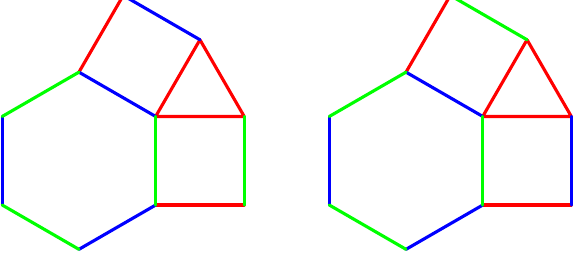
Fig. 5: Possible colouring’s of